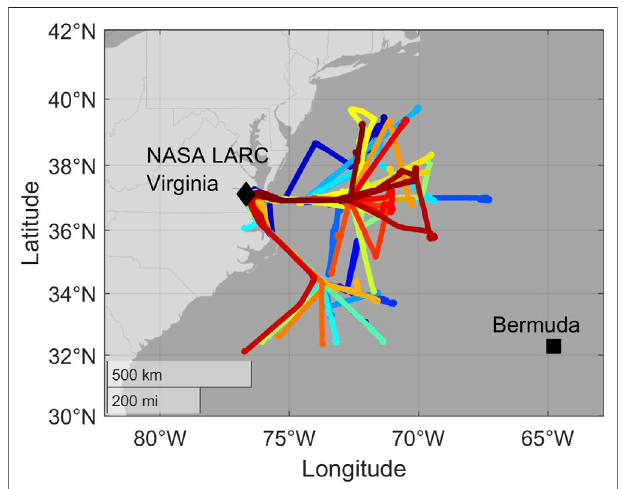
FIGURE 1 | Flight tracks from the 35 two-aircraft research fl ights that were carried out during the fi rst two deployments of ACTIVATE in the winter and summer of 2020. Each fl ight track color corresponds to a different ACTIVATE research fl ight.